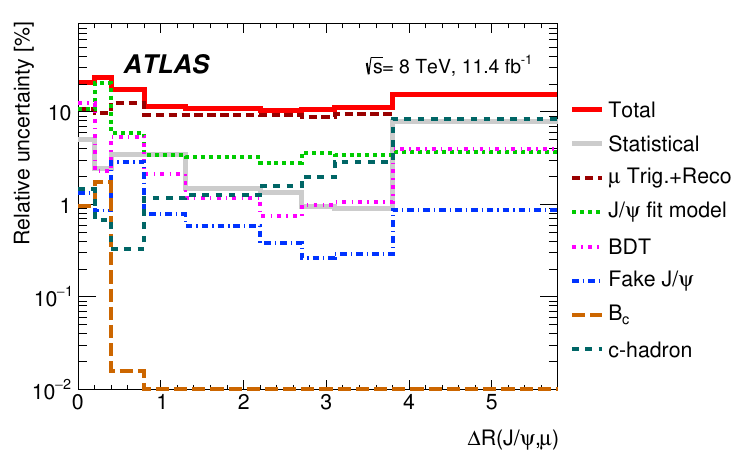
Figure 5 . The contribution from each systematic uncertainty source as a function of (cid:1) R ( J= ; (cid:22) ). Details of the di(cid:11)erent contributions are given in the